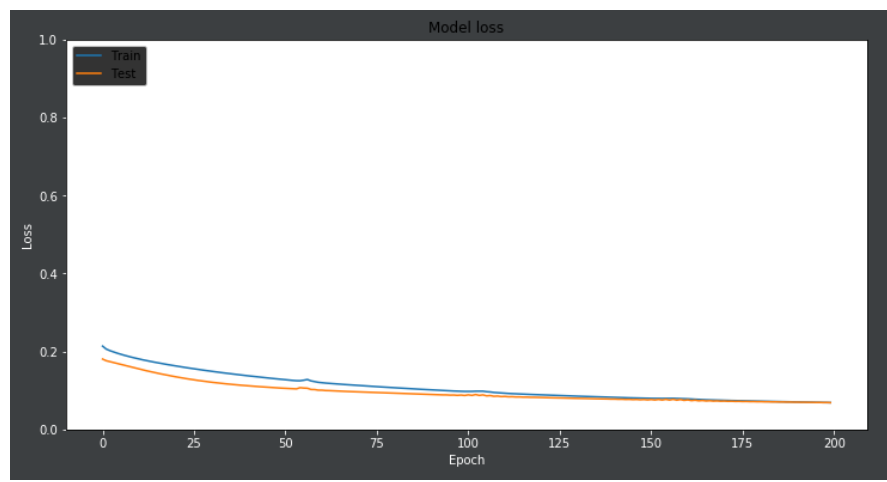
Figure 16. Accuracy plot using dataset found in reference [40]. Appl. Sci. 2019 , 9 , x